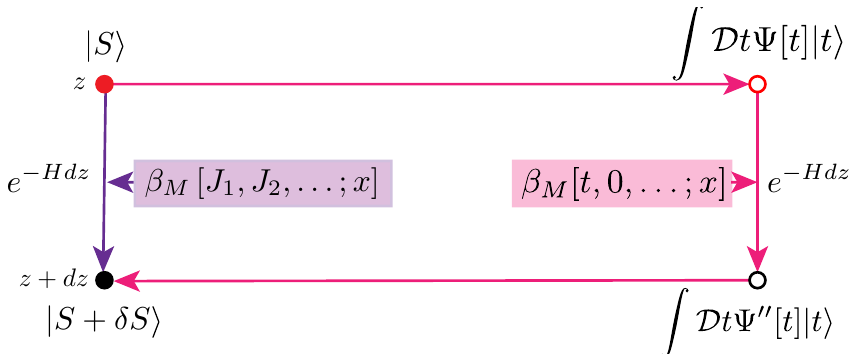
Figure 2: A field theory S at scale z is represented by a quantum state | S 〉 on the upper left corner. The vertical arrows represent an infinitesimal step of coarse graining generated by H . The coarse graining directly applied to | S 〉 , denoted as the vertical arrow on the left, maps | S 〉 to | S + δ S 〉 . S + δ S is the renormalized action at scale z + dz , and δ S encodes the information on the full β -functions. Alternatively, | S 〉 is first written as a linear superposition of basis states whose action only includes single-trace deformations through the horizontal arrow that points to the right. The result of the coarse graining applied to that state, denoted as the vertical arrow on the right, only depends on the β functions defined in the space of single-trace couplings. The resulting coarse grained state on the lower right corner is finally mapped back to a renormalized action on the lower left corner. The commutativity of the diagram implies the full β -functions are fixed by the β -functions defined in the subspace of single-trace